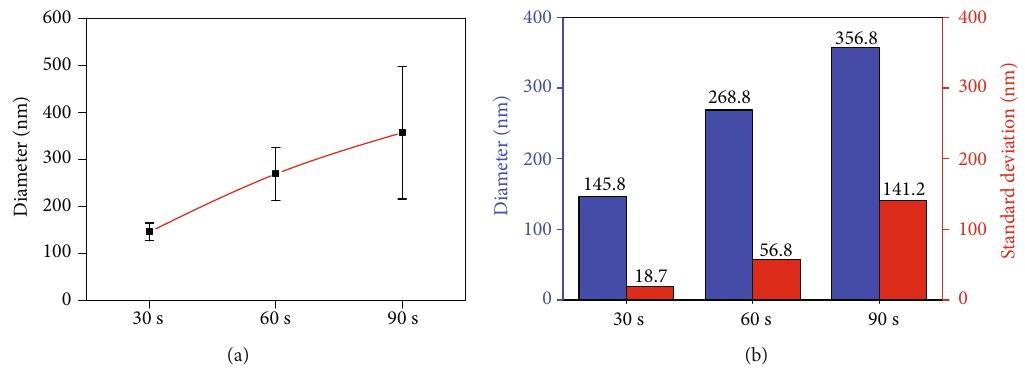
Figure 3: (a) Plotted graph showing the correlation between the average CNT diameters and microwave time; the standard deviations are plotted as the error bars. (b) Columns showing the direct comparison of the average diameters and corresponding standard deviations of the CNTs synthesized from 30 s, 60 s, and